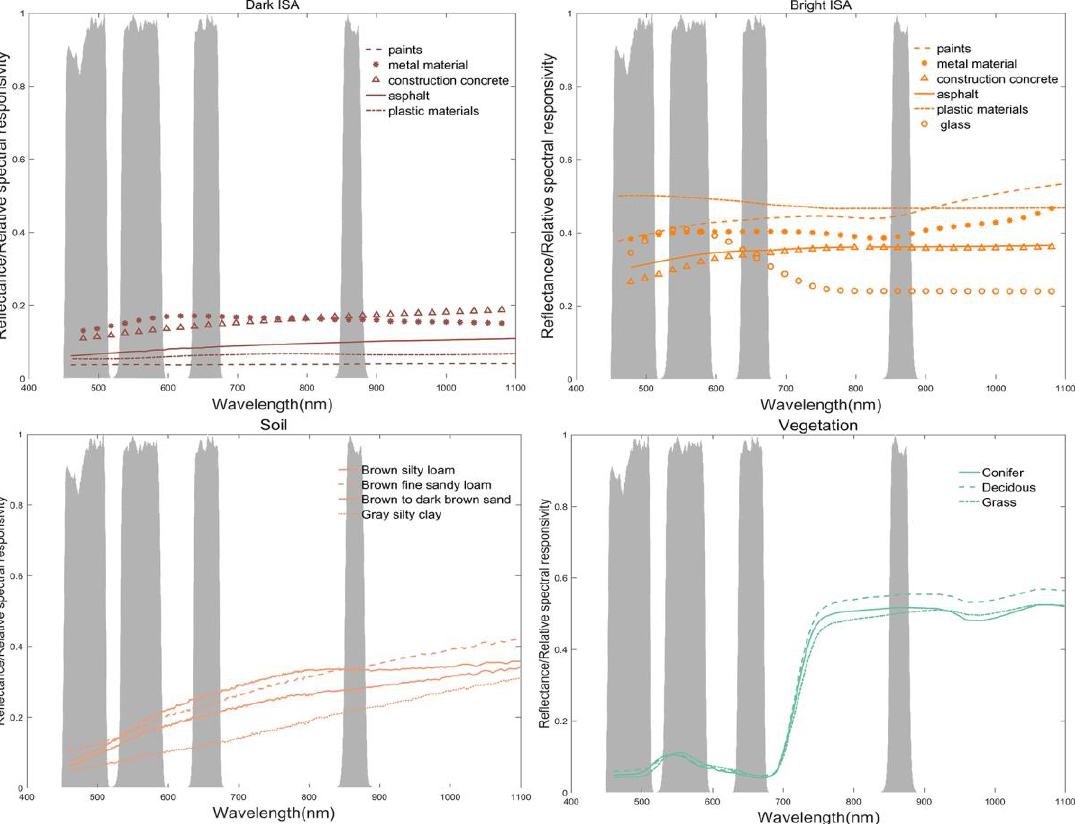
Figure 2. Spectral curves of urban components in the spectral libraries. The four components were defined as dark ISA, bright ISA, soil, and vegetation (dark gray columns represent, from left to right, blue, green, red, and near-infrared (NIR) band locations of Landsat 8).